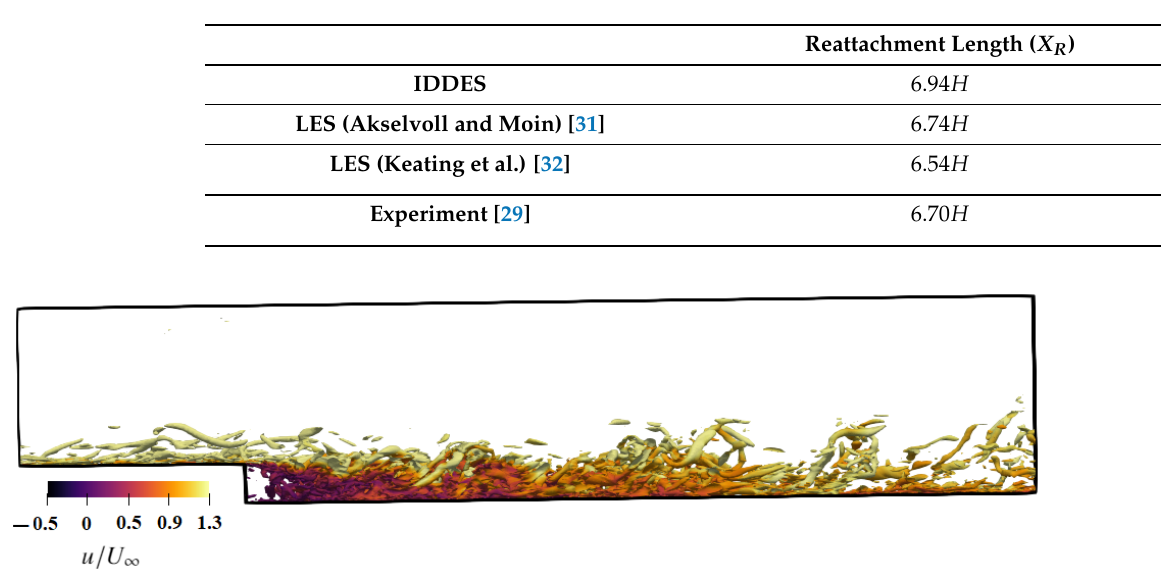
Table 1. Comparison of reattachment lengths obtained by the IDDES model and available experi- mental and LES data.